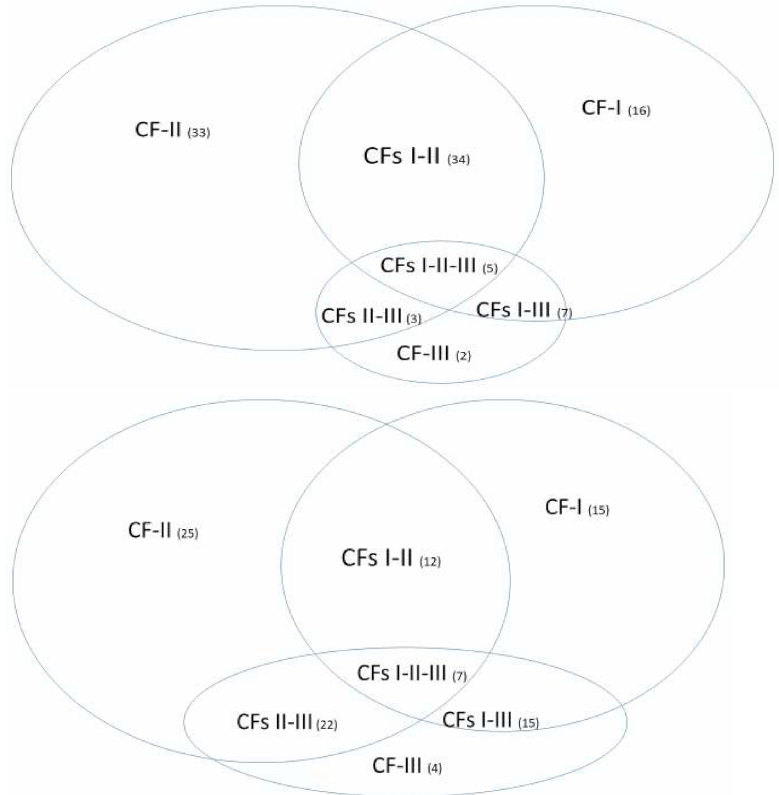
Figure 3. Venn diagrams of COVID-19 subtypes. The top panel is based on TPM data, and the bottom panel is based on expected counts data. The legend CF-I corresponds to the classifier formed by (KIAA1614, MND1, and SMG1); the legend CF-II corresponds to the classifier formed by (ABCB6, MND1, SMG1); the legend CF-III corresponds to the classifier formed by RIPK3; the legend CFs I-II corresponds to the combined classifier formed by (ABCB6, KIAA1614, MND1, SMG1); the legend CFs I-III corresponds to the combined classifier formed by (KIAA1614, MND1, RIPK3, SMG1); the legend CFs II-III corresponds to the combined classifier formed by (ABCB6, MND1, RIPK3, SMG1); the legend CFs I-II-III corresponds to the classifiers formed by all five genes. The numbers in the parentheses are the numbers of COVID-19 positive patients who are classified into the specific groups by the component classifiers or combined classifiers,